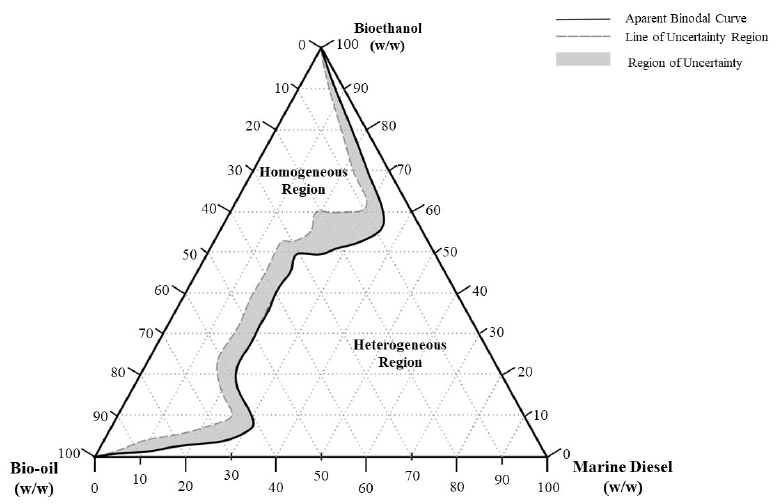
Figure 2. Phase Diagram of FPBO—sugarcane ethanol—Marine Diesel ternary system (25 °C). Adapted from Galindo et al. [5].